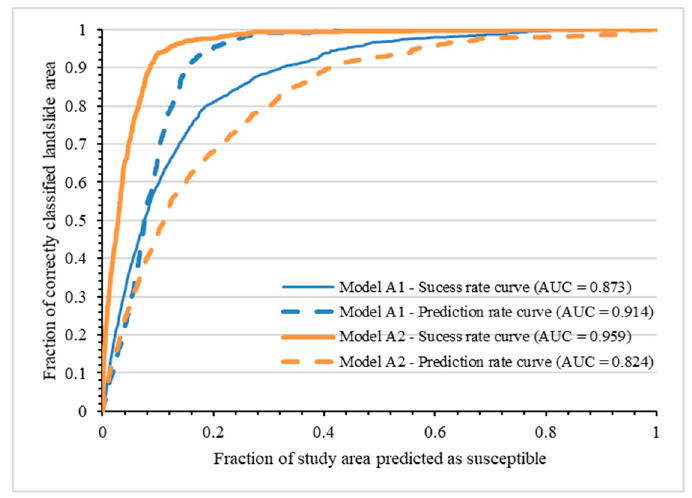
Figure 8. Success rate and prediction rate curves of landslide susceptibility Models A1 and A2.